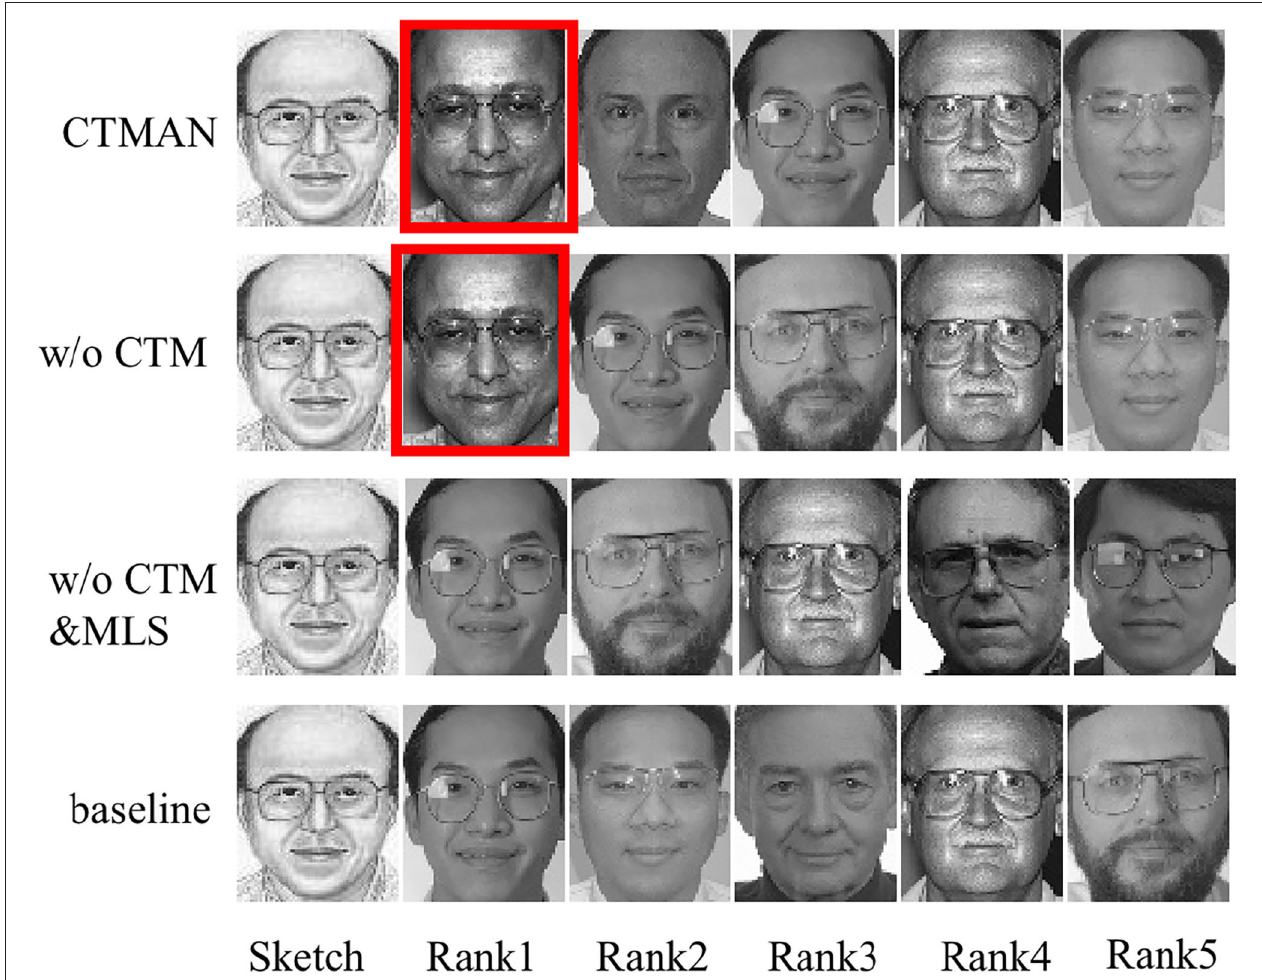
FIGURE 7 | The top five matching photos of CTMAN, w/o CTM, w/o CTM&MLS, and baseline on the S3 setup, images in red box are the